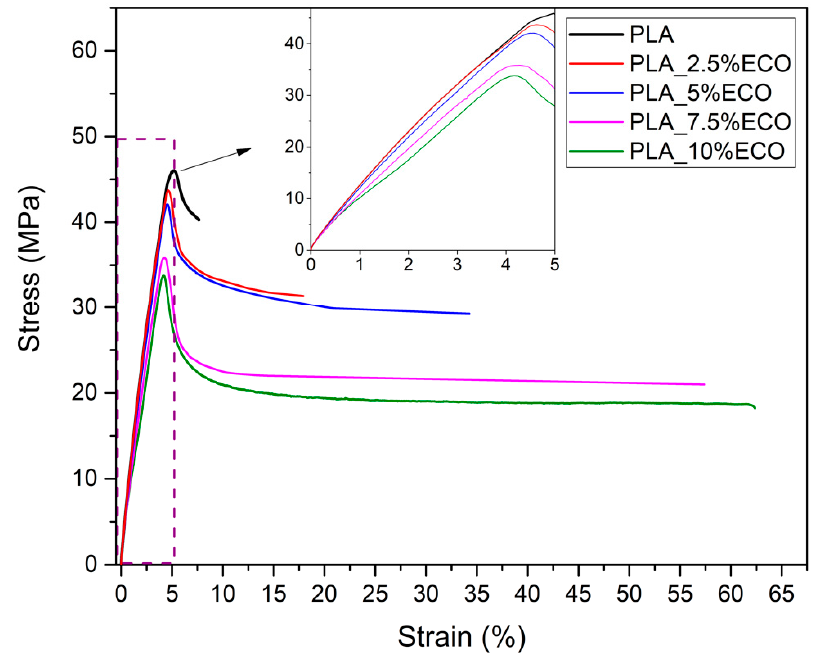
Figure 2. Plot evolution of characteristic stress-strain curves of PLA with different epoxidized chia seed oil (ECO) contents.